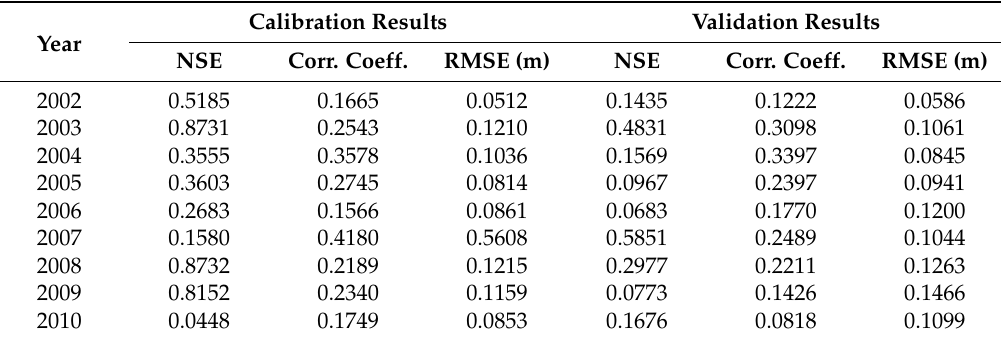
Table 1. Results of neural network downscaling approach with uninterpolated points for calibration (50% calibration, 50%